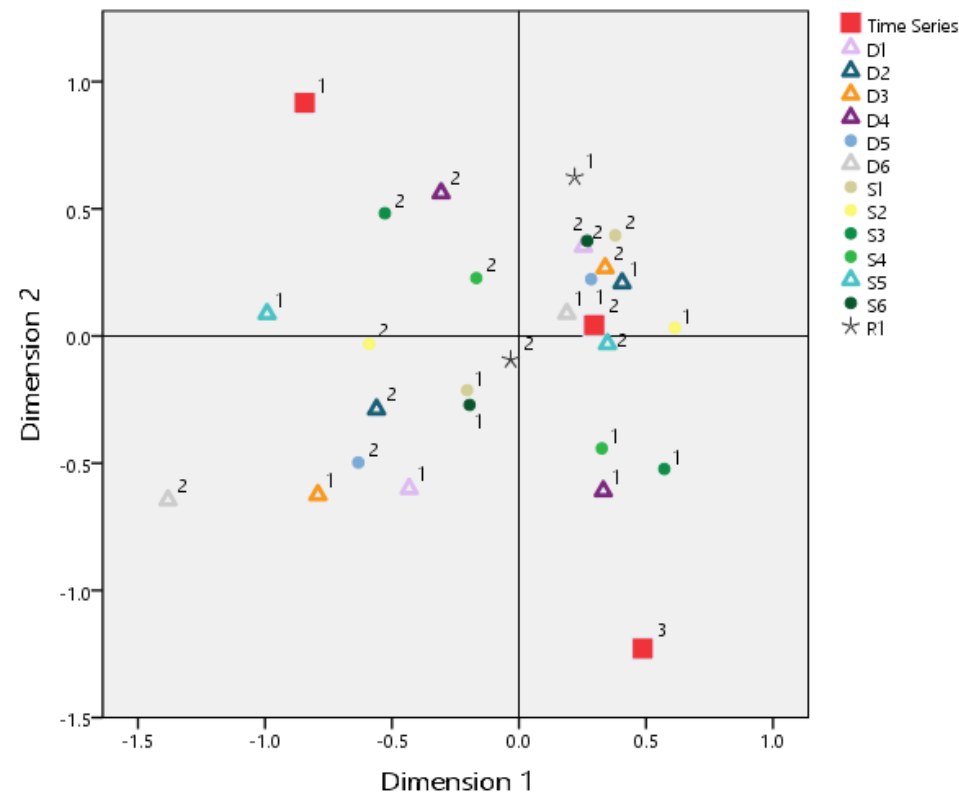
Figure 8. Corresponding analysis of renewal timing and UPS attributes.